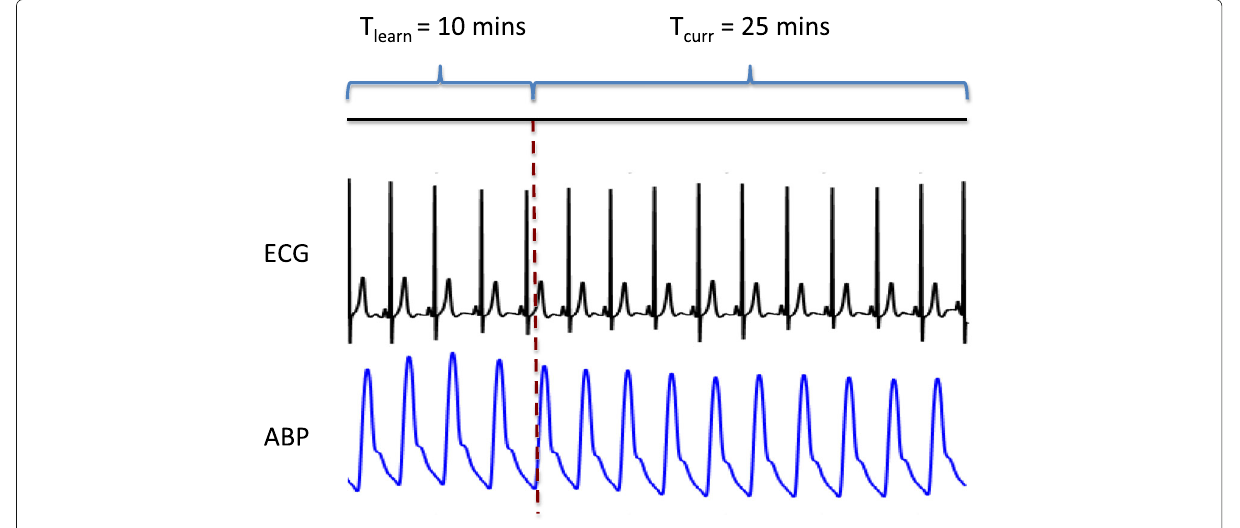
Fig. 15 Timeline for T learn and T